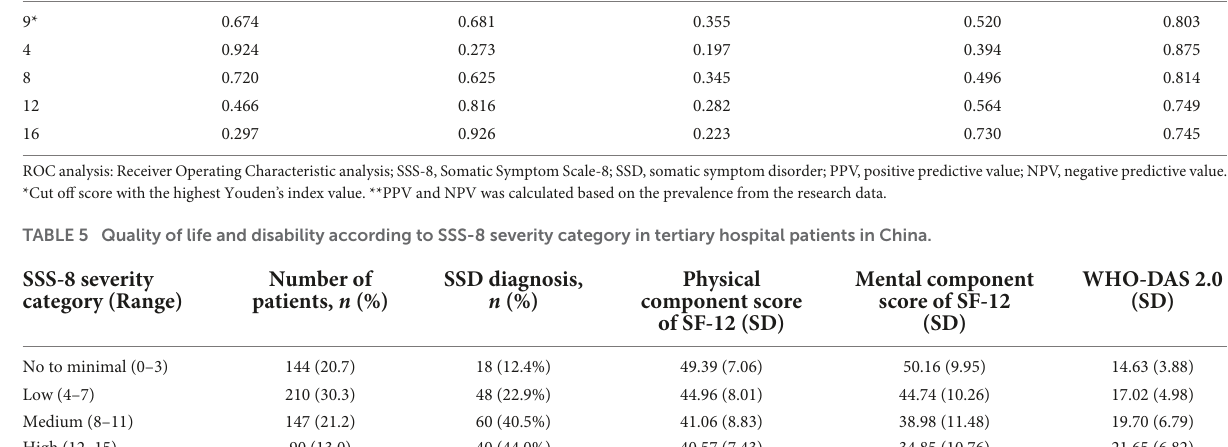
TABLE 4 Result of the ROC analysis of the SSS-8 sum score for the SSD diagnosis. Cutoff